Question: Judging by this figure, is the value going up or going down?
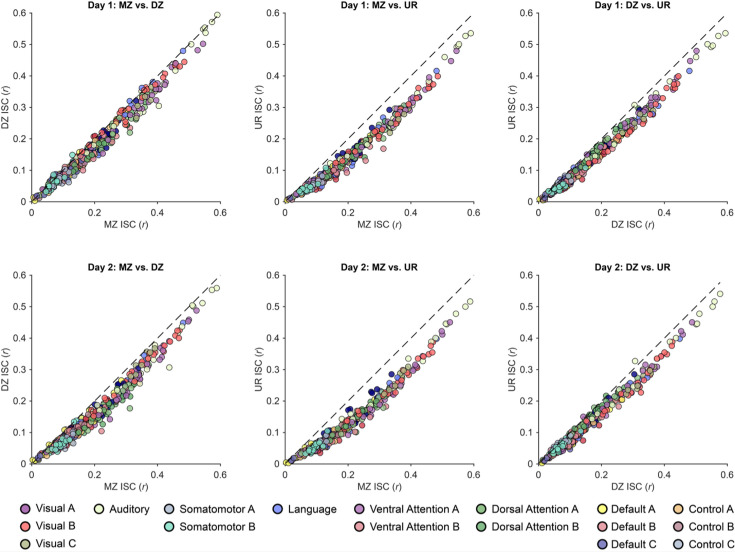
Answer: increasing